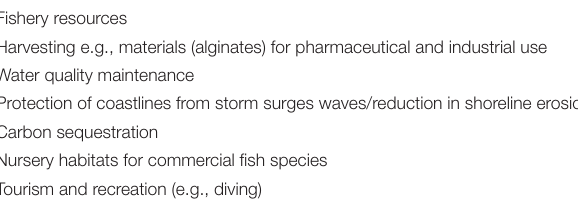
TABLE 2 | Ecosystem services provided by kelp included in the